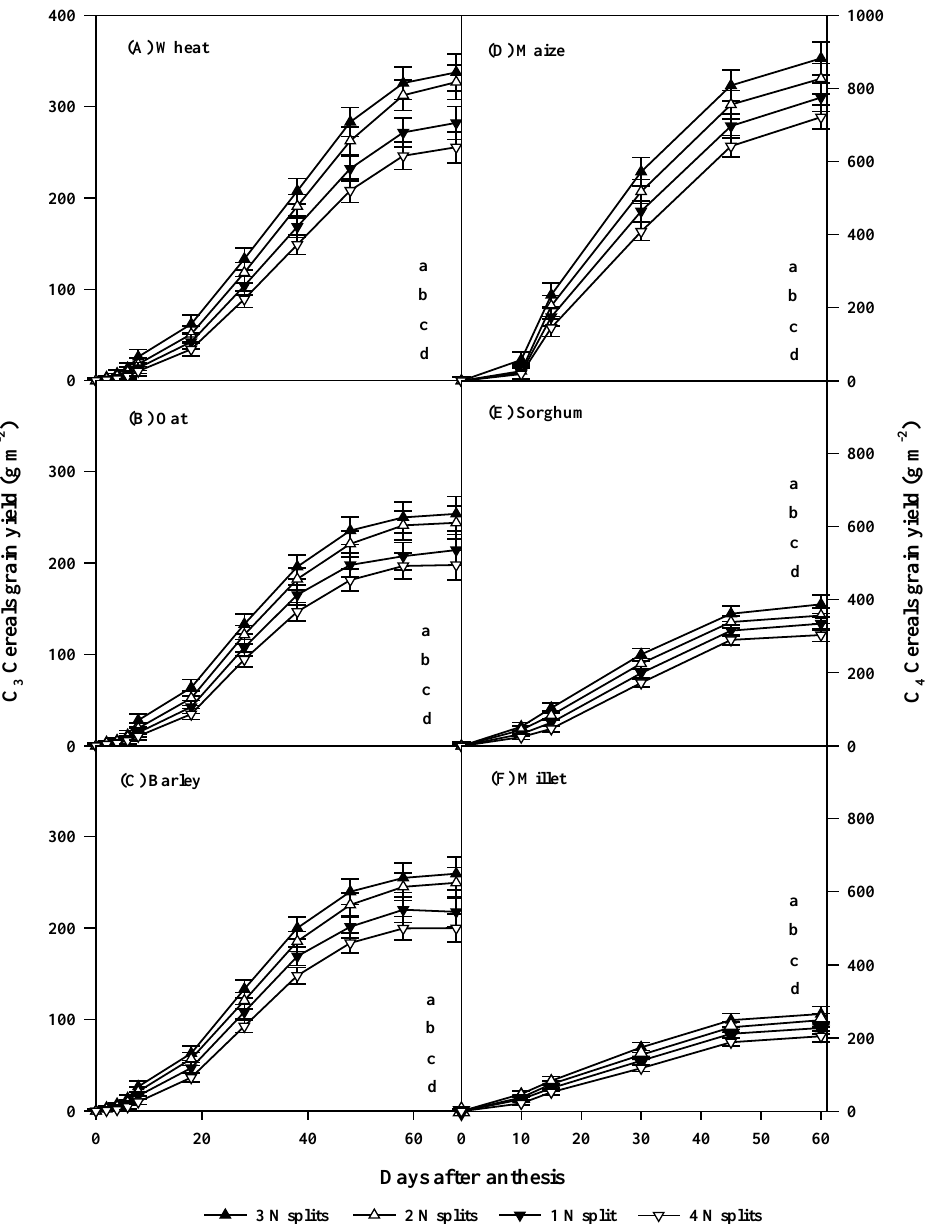
Figure 6. Grain yield of winter C 3 ( A – C ) and summer C 4 ( D – F ) cereals under split N application regimes. Bars and letters represent standard error and significance, respectively.